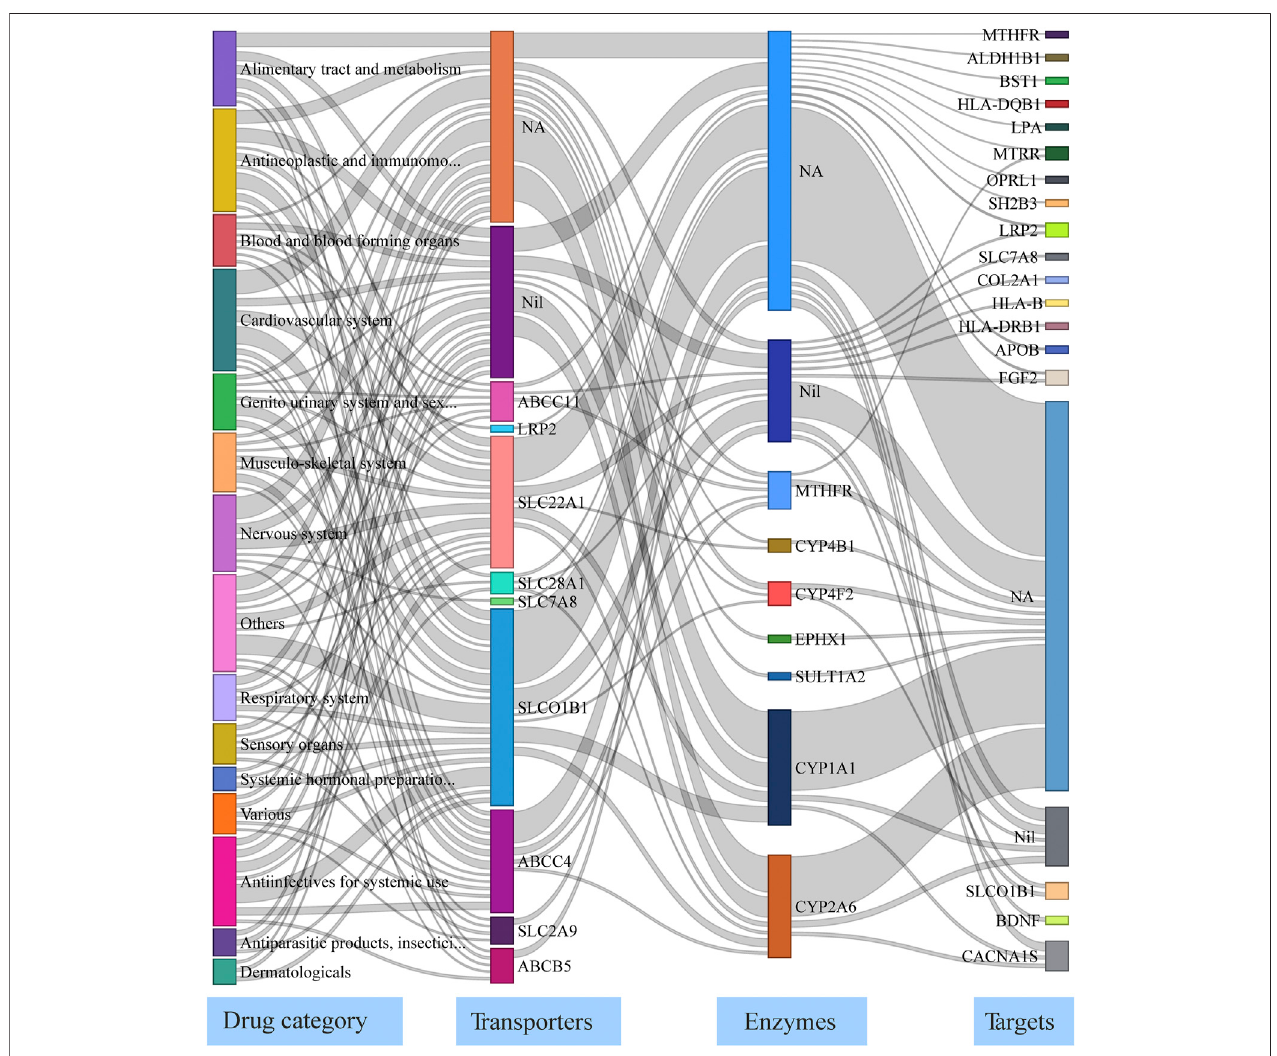
FIGURE3| Drugpathwaymapdescribingfunctionally-impairedpharmacogenesinthecentralHanChinesepopulation.Thefourcolumnsinthemaprepresentthe major drug category affected by putatively deleterious variants, transporter/carrier genes, enzyme genes, and target genes. NA: None Affected; Nil: No known genes.